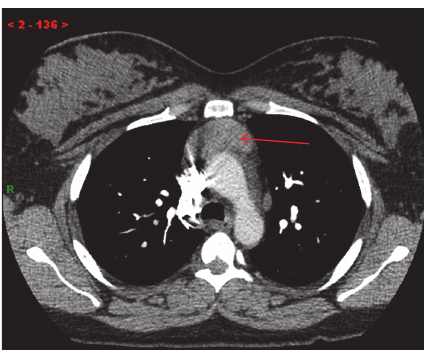
Figure 1: Axial CTA through the level of the aortic arch shows a homogenous anterior mediastinal mass (red arrow).